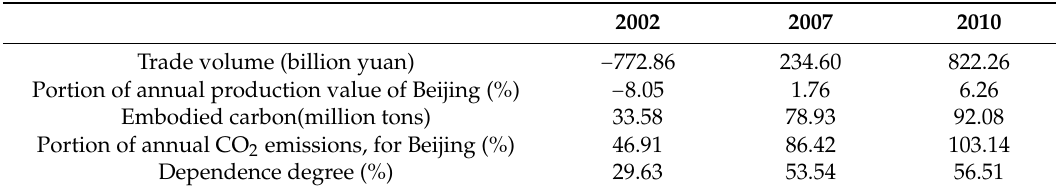
Table 3. Input and output volumes of trade, and embodied carbon flowed out from Beijing to other provinces.